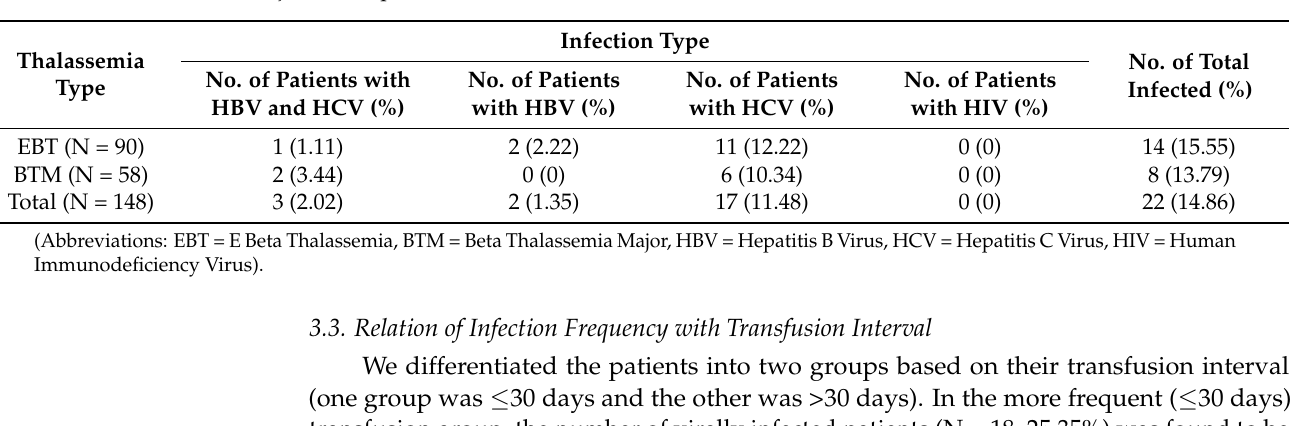
Table 2. Frequency of viral mono-infection and co-infection among the transfusion-dependent E-beta thalassemia (EBT) and Beta thalassemia major (BTM) patients.